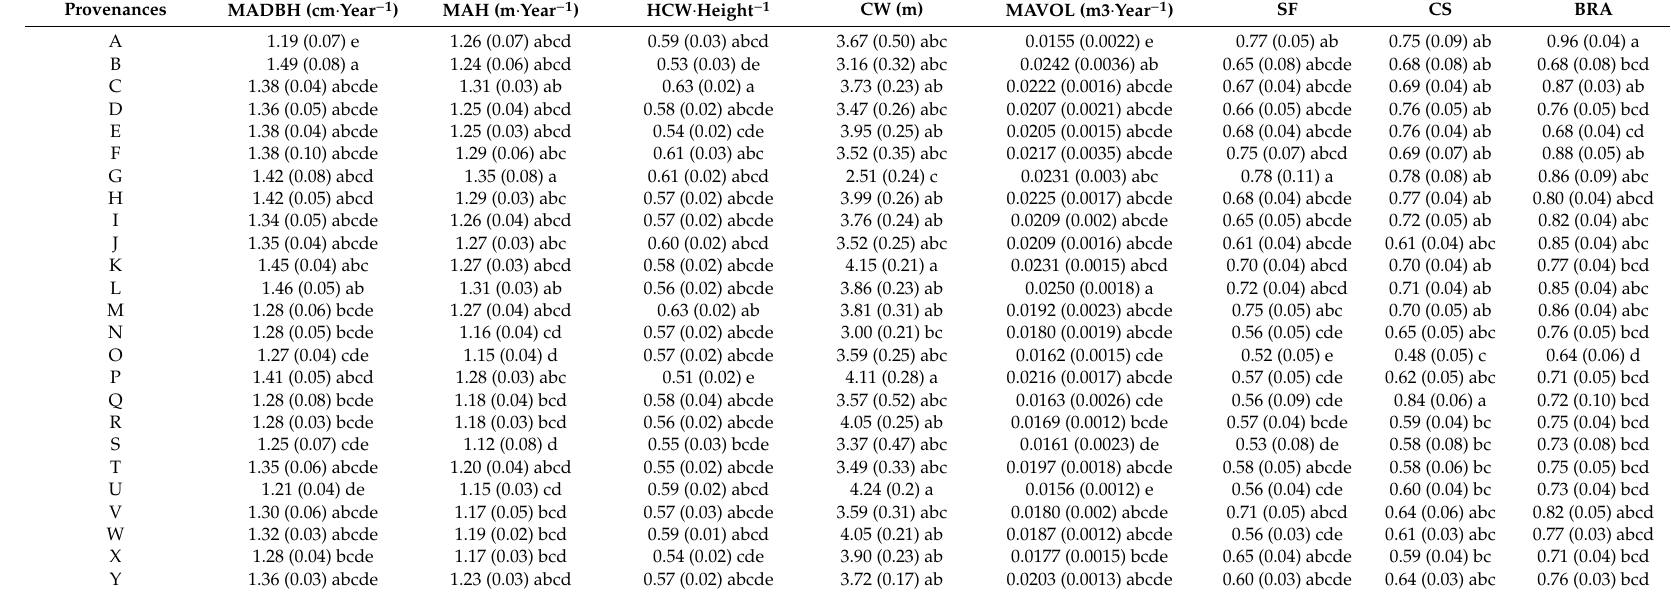
Table A2. Growth and quality traits for 25 provenances of Betula alnoids at Mengla